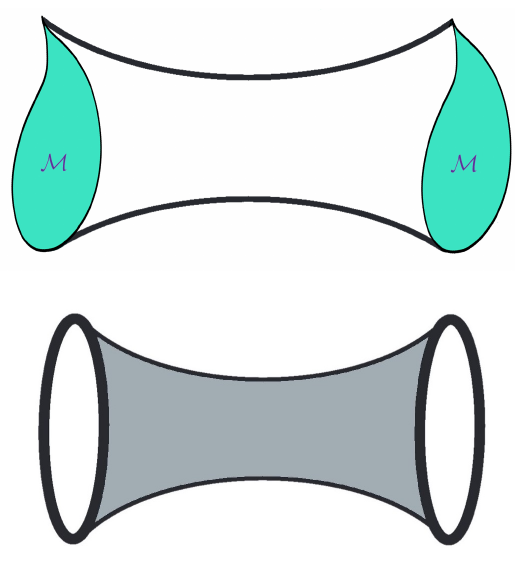
Figure 4. Coupling-dependent observables O ( τ ) have nonzero variance in the SL (2 , Z ) ensemble. This correlation may be represented by a “wormhole” in an abstract space containing two copies of the N = 4 SYM conformal manifold M (left). At large N , this invites a geometric re-interpretation, as a spacetime wormhole in AdS 5 × S 5 with strongly coupled planar N = 4 SYM living on the conformal boundaries